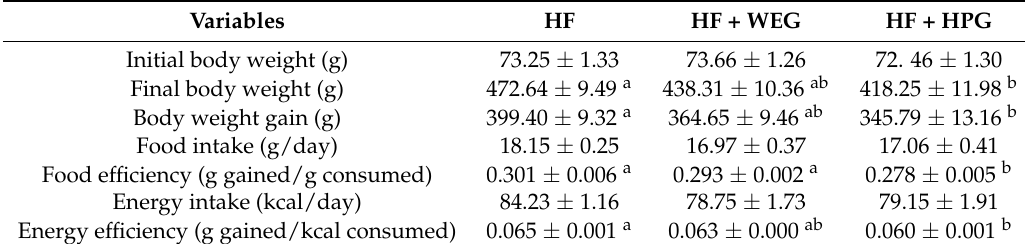
Table 1. Effects of WEG and HPG on physiological variables.